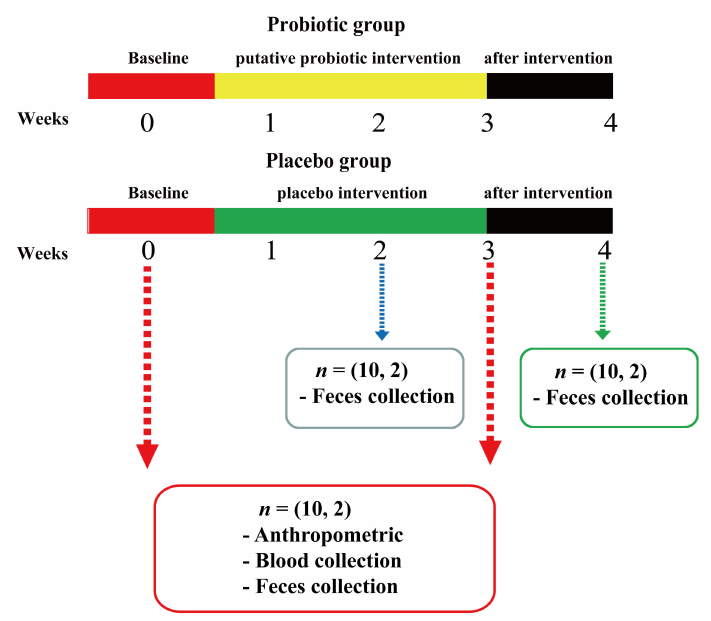
Figure 1. Schematic diagram indicating probiotic and placebo group intervention of the volunteers. Each group took the probiotic or placebo for three weeks. Blood samples of volunteers were collected at 0 and 3 weeks, and fecal samples were collected at 0, 2, 3, and 4